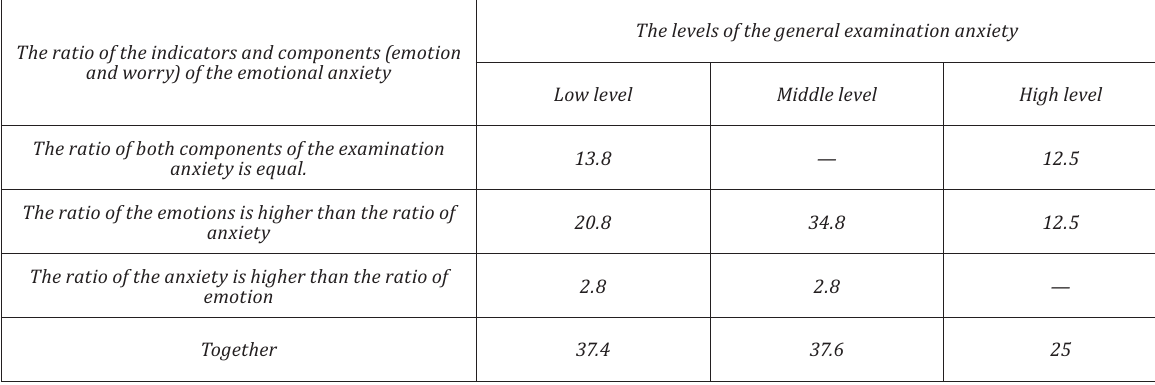
Table 2. The assessement of factors according to Cattell in the students with different levels of the examination The value of the secondary factor F «low The value of the first factors of R. Cattell's test (stems) anxiety – high anxiety» 2